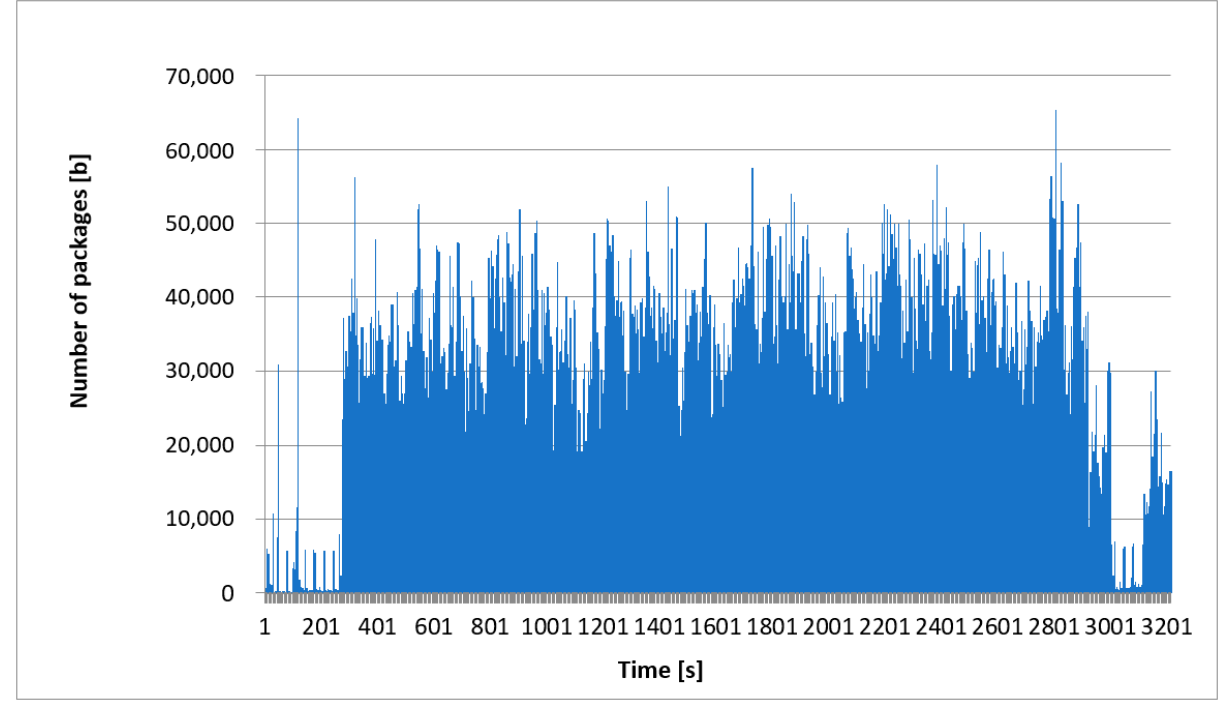
Figure 2. Overall network traffic.